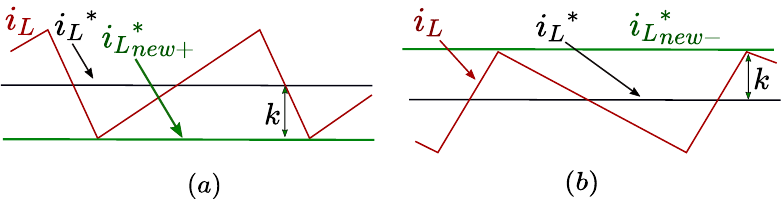
Figure 6. Pictorial representation of reference correction over a switching cycle ( a ) Positive half cycle. ( b ) Negative half